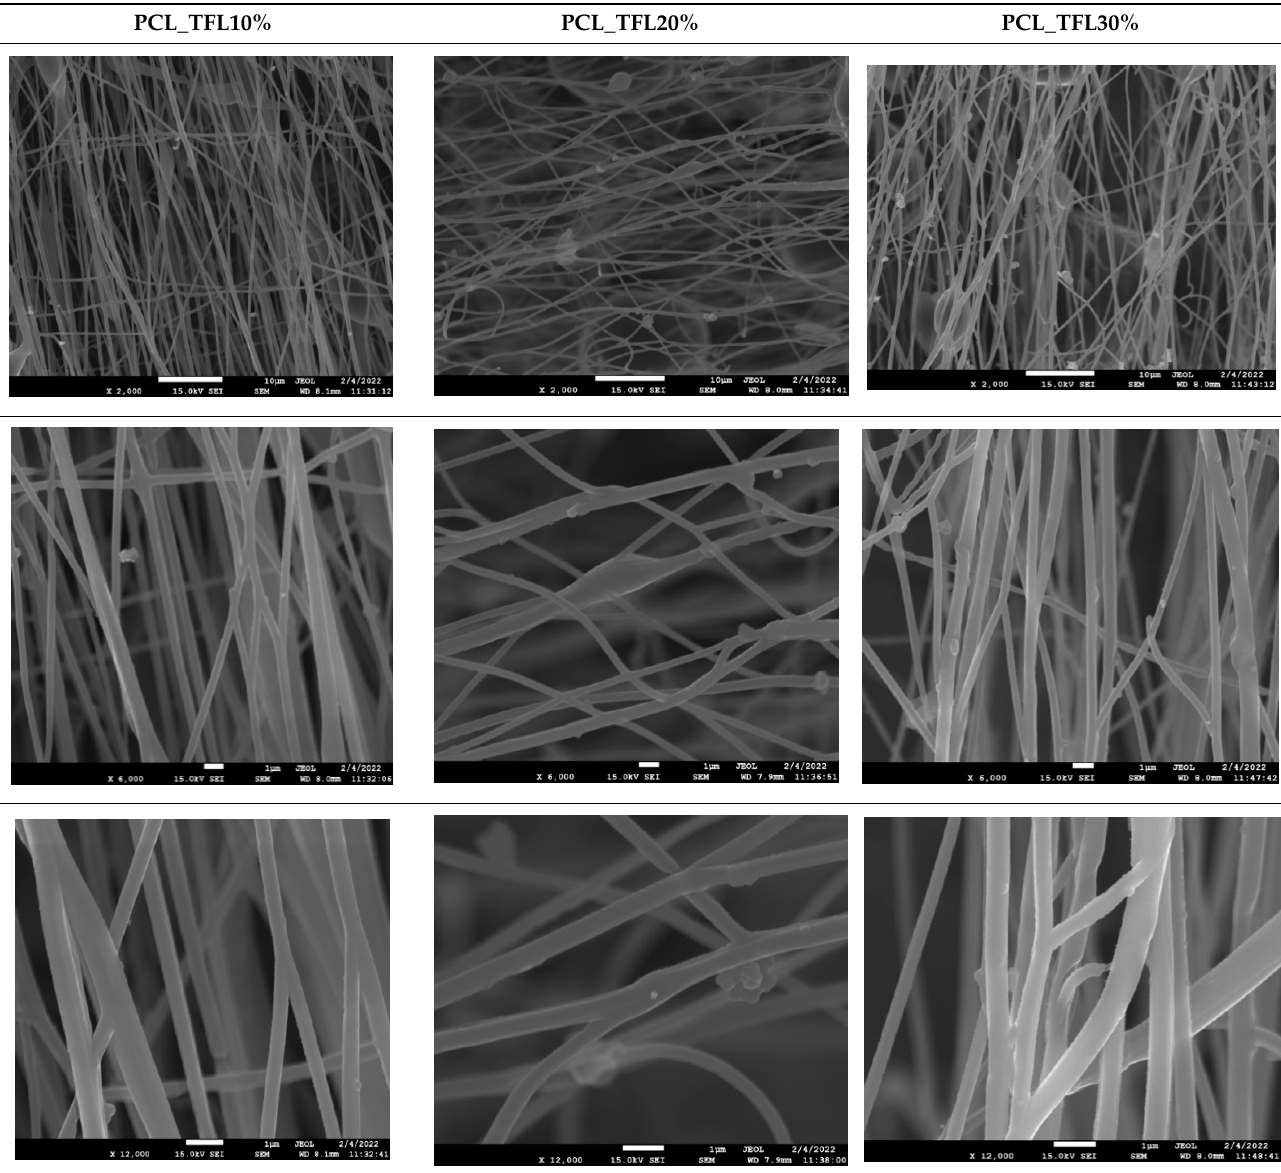
Table 7. Mean fibers’ diameter ( μ m), standard deviation, highest and lowest diameter ( μ m) value for drug-loaded fibers.